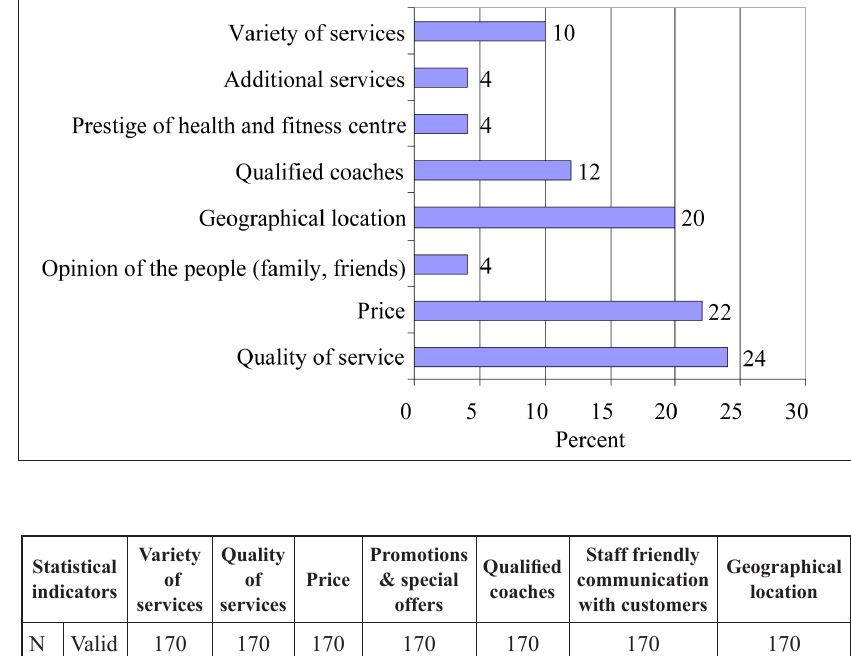
Figure 1. Distribution of the motivators influencing consumers’ selection of a wellness-fitness centre in Kaunas